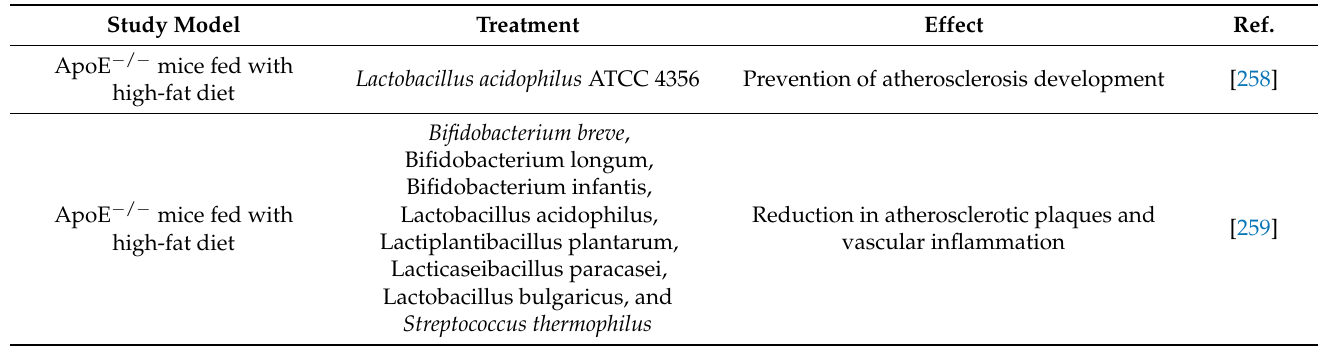
Table 4. Murine models and clinical trials on the use of probiotics in